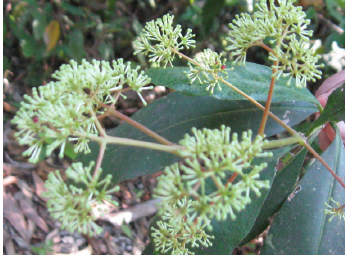
Figure 1 . Inflorescence of Ixora brachiata